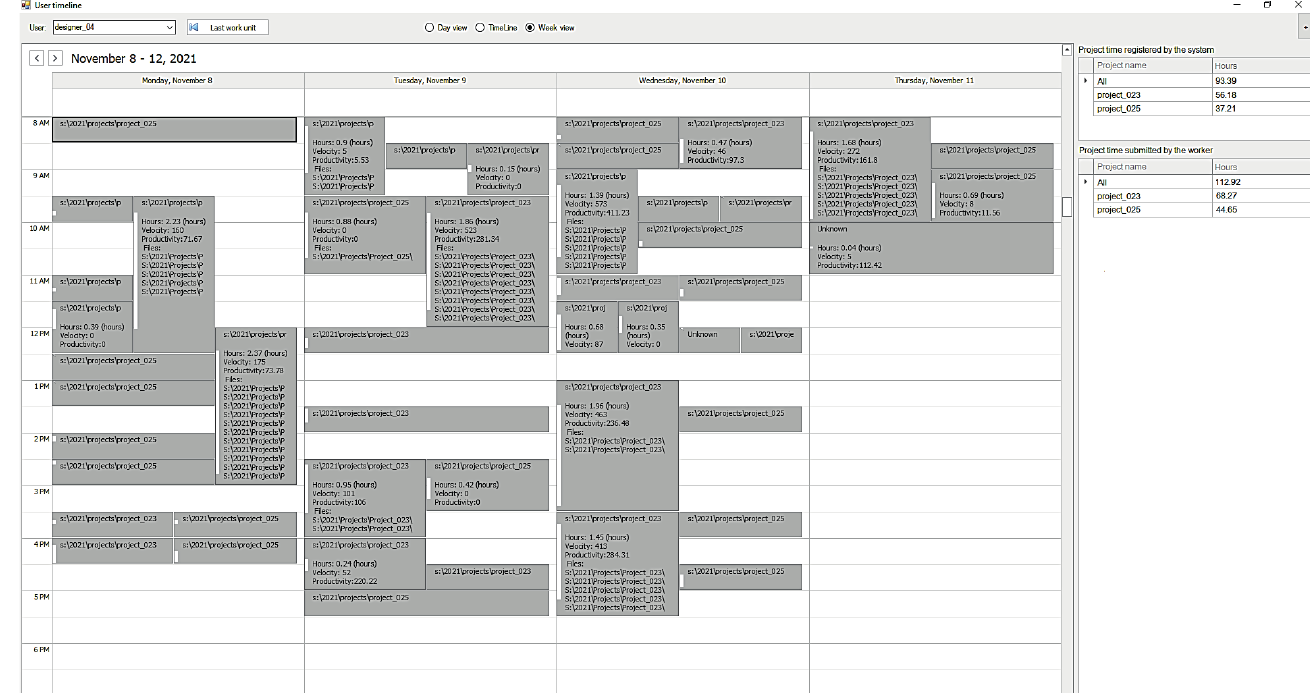
Fig. 2. An overview of engineering system designer’s weekly work (with time amount registered by the system vs submitted by t he worker). The working item, which demonstrates time spent by a items with productivity more than 60 % are highlighted as particular designer while performing operations within AutoCAD, is highlighted as red, yellow or green (like semaphore colours) in compliance with item productivity expressed by percent. Working items with productivity 0–30 % are highlighted as red, working items with productivity 31–60 % are highlighted as yellow and the remaining working